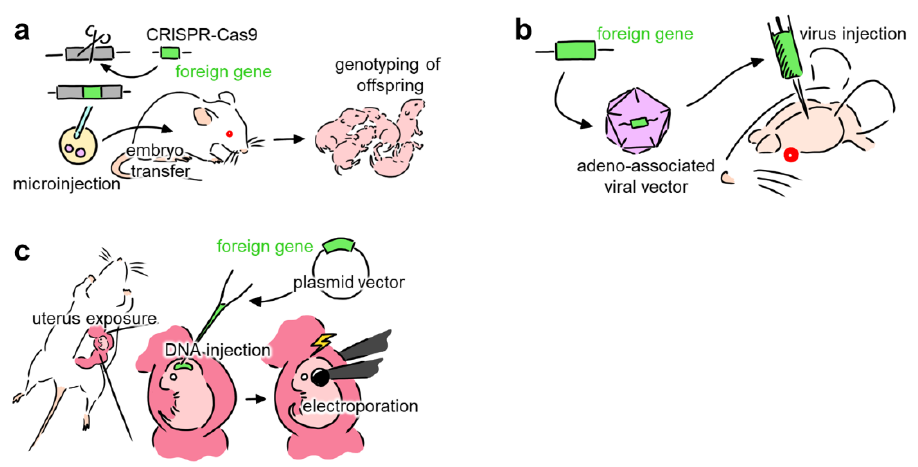
Figure 1. Overview of methods that introduce foreign genes into neurons. ( a ) Schematic of creating genetically modified animals that express opsins. The DNA sequence of the target animal is modified and injected into embryos. The embryos are then transferred to the host animal, where they mature into offspring. ( b ) Schematic of transduction enabling the expression of opsins using viral vectors. DNA segments with foreign genes are encapsulated into a viral vector. After injecting the viral vectors into a specific target region of the brain, the virus transfects neurons in that region, inducing opsin expression. ( c ) Schematic of in utero electroporation. Using laparotomy, the uterus of the pregnant animal is exposed. Then, DNA plasmid vectors with the target genes are injected into the ventricle of the fetus. Electroporation is then used to transfer the DNA plasmids into the